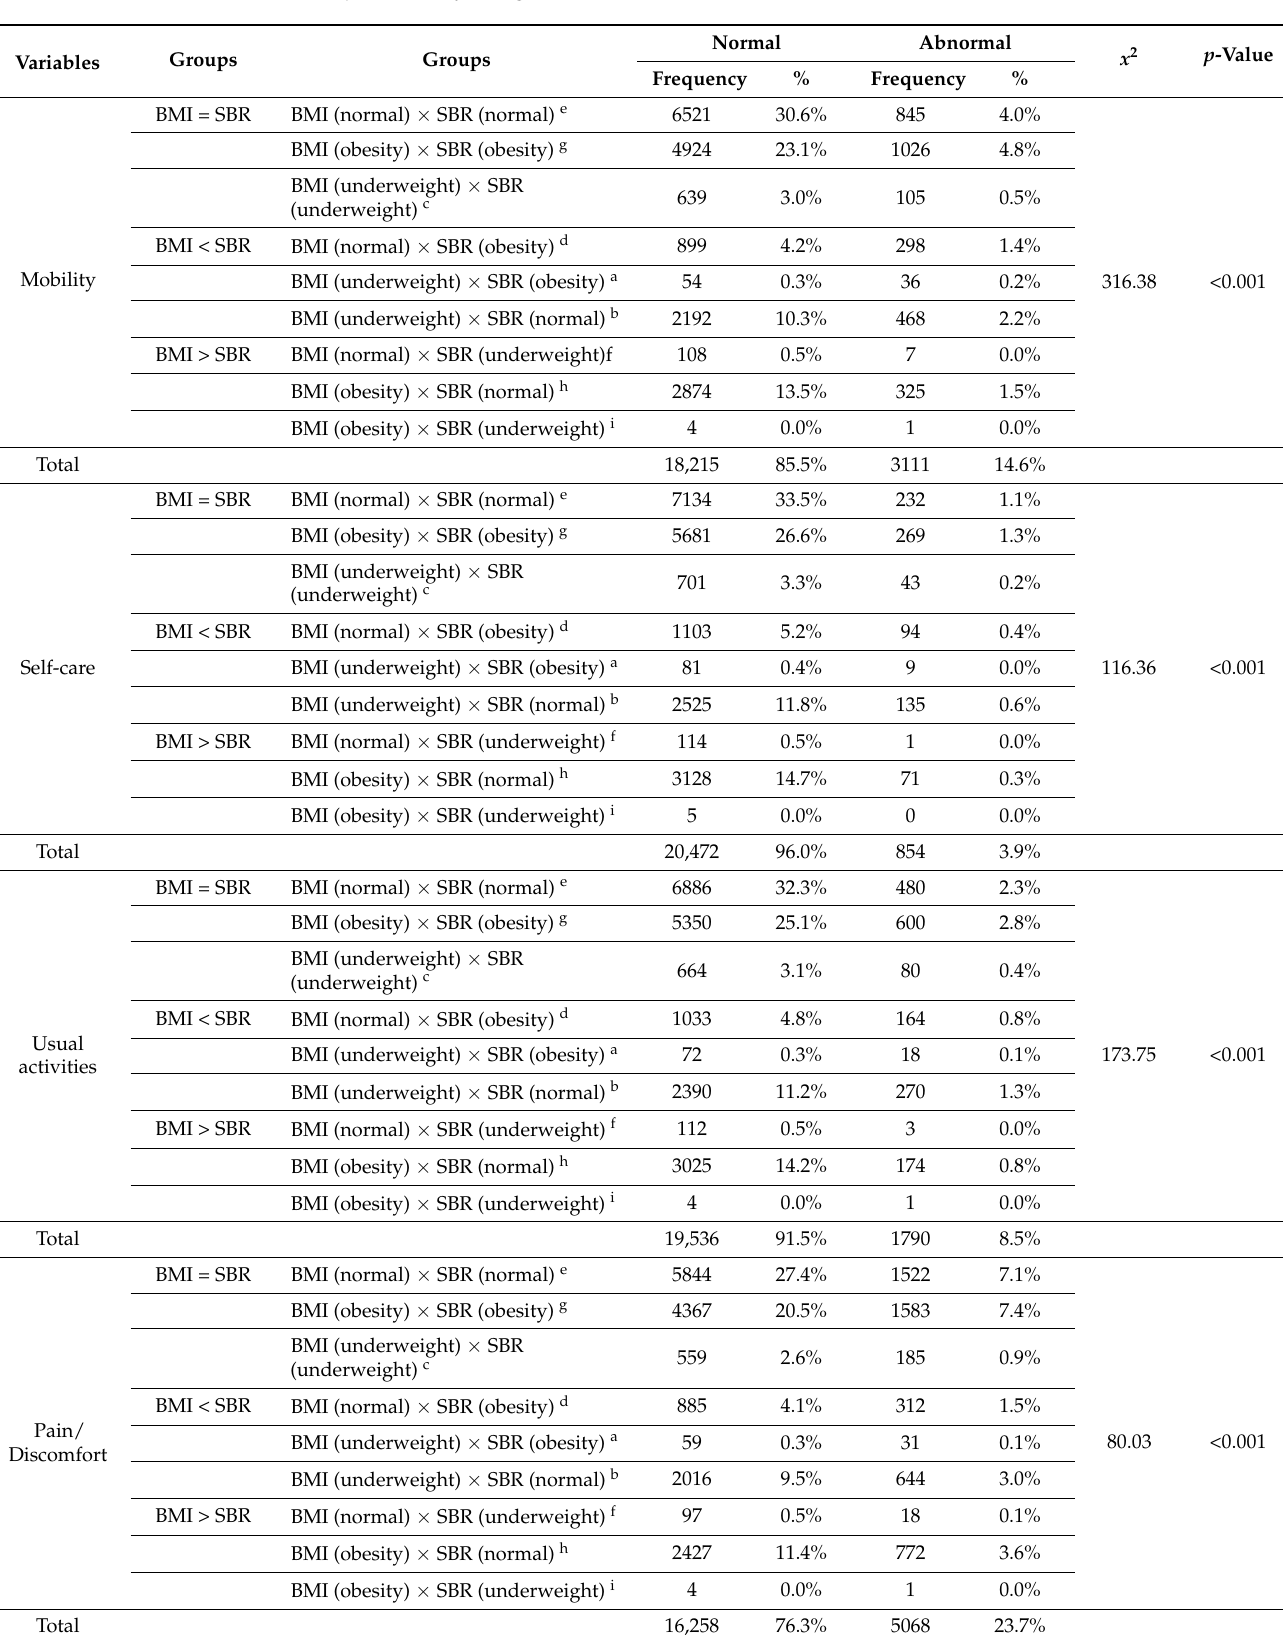
Table 4. Comparison of health-related quality of life according to difference between BMI and subjective body